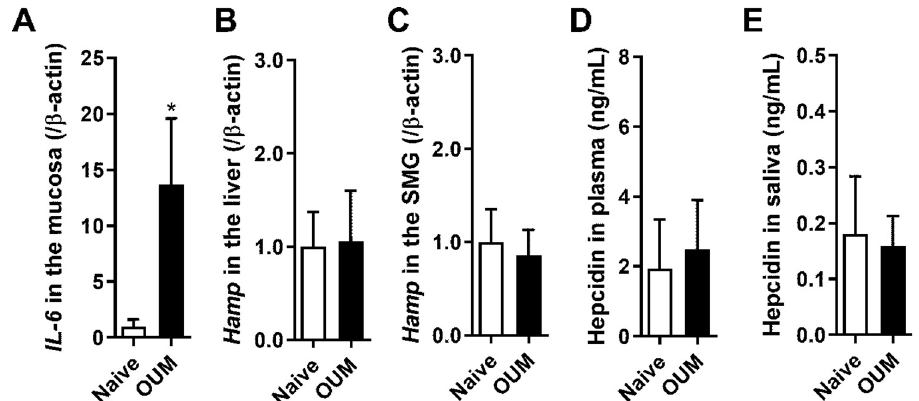
Fig 4. Changes in IL-6 and Hamp mRNA and hepcidin levels in OUM rats. n = 4 in each group. * p < 0.05 compared with Naive, Unpaired t-test. (A) Relative expression levels of IL-6 (IL-6 mRNA) in the oral mucosa. (B, C) Relative expression levels of Hamp in the liver (B) and the submandibular gland (SMG) (C). (D, E) Hepcidin levels in plasma (D) and saliva (E) in Naive and OUM.